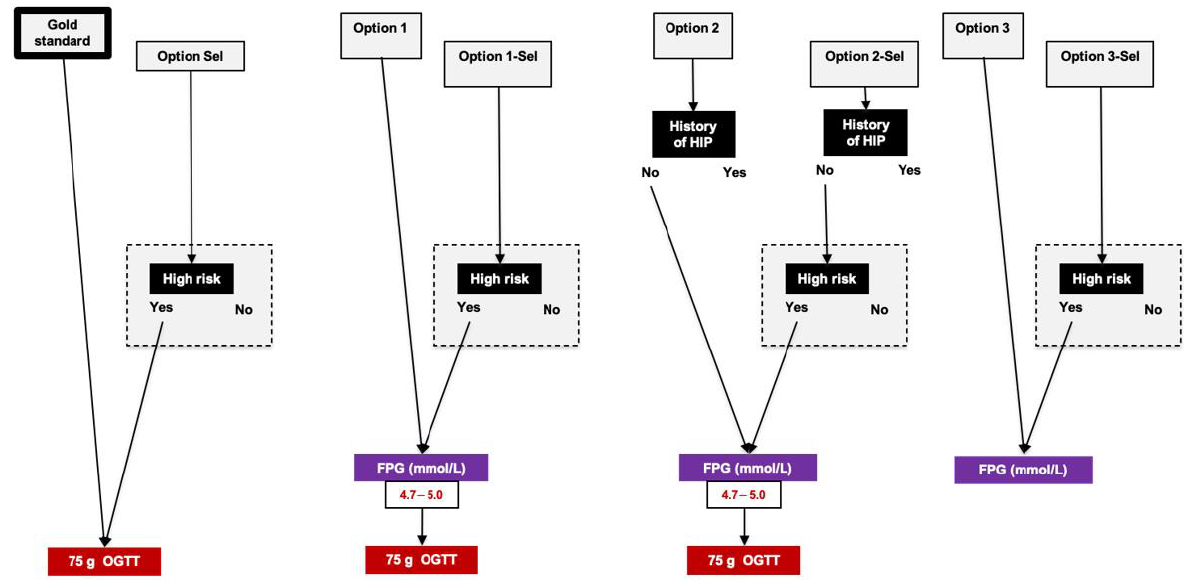
Figure 1. Reference standard and options that were evaluated after 22 weeks of gestation. Reference standard refers to universal screening with oral glucose tolerance test between 22 and 30 weeks of gestation (75 g oral glucose tolerance test, IADPSG/WHO criteria). We evaluated seven options, applying universal (Options 1, 2 and 3) or selective screening (Options Sel, 1-Sel, 2-Sel and 3-Sel). Women were considered at high risk according to Australian–New Zealand risk factors (please see text). OGTT: oral glucose tolerance test; 1h-PG and 2h-PG: plasma glucose value 1 and 2 h after 75 g oral glucose tolerance test, respectively; DIP: diabetes in pregnancy; FPG: fasting plasma glucose; GDM: gestational diabetes mellitus; HIP: hyperglycemia in